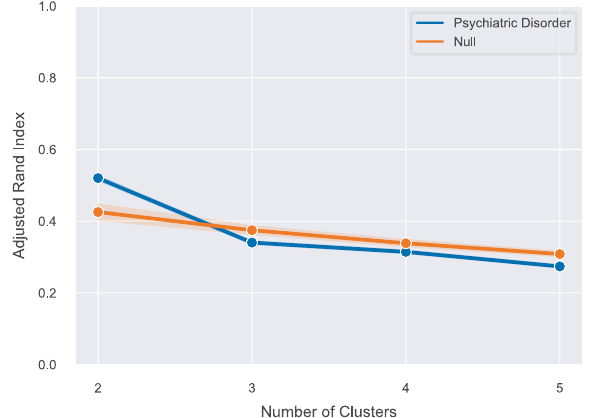
Fig. 1 The Adjusted Rand Index for K clusters of the psychiatric disorder group compared to the null distribution obtained from random permutations. Data are represented as mean ±95% CI for each clustering solution between 2 and 5 clusters. The highest ARI was for a two-cluster solution of individuals with psychiatric